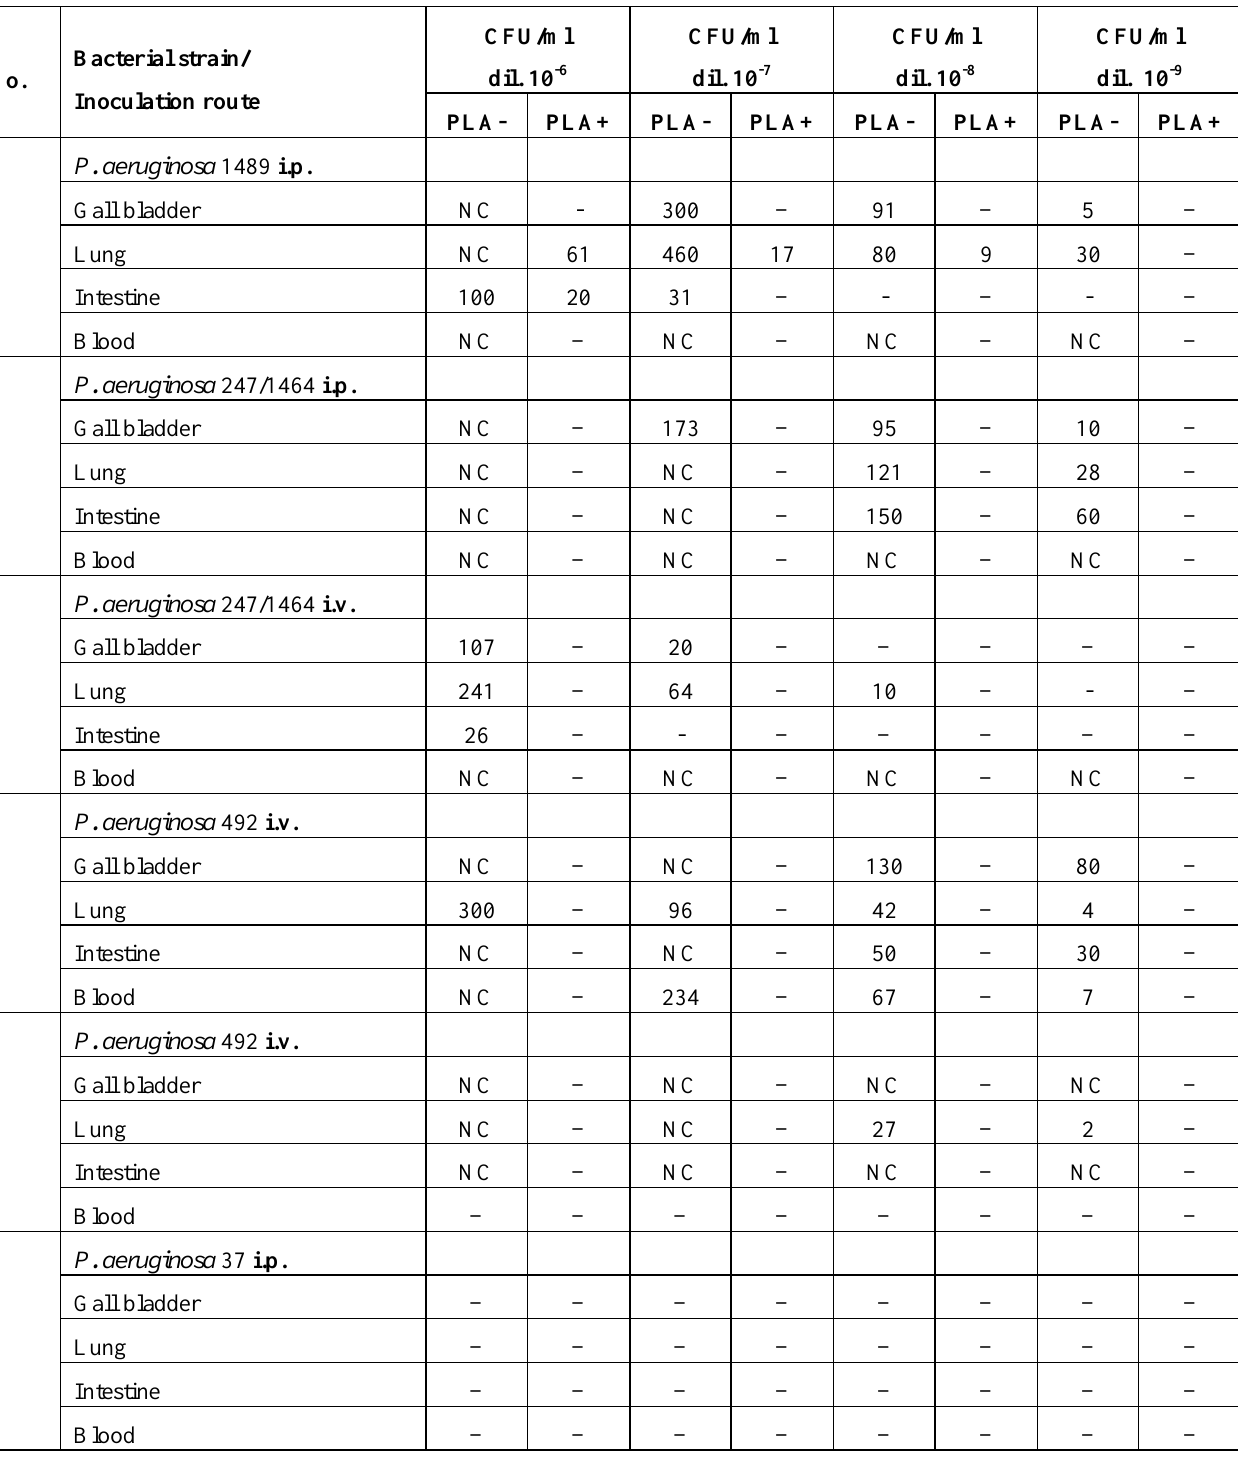
Table 3. Viable cell counts (CFU/ml) in internal organ tissues of animal batches infected with untreated (PLA-) and PLA treated (PLA+) P. aeruginosa cultures. Bacterial strain/ No. Inoculation route